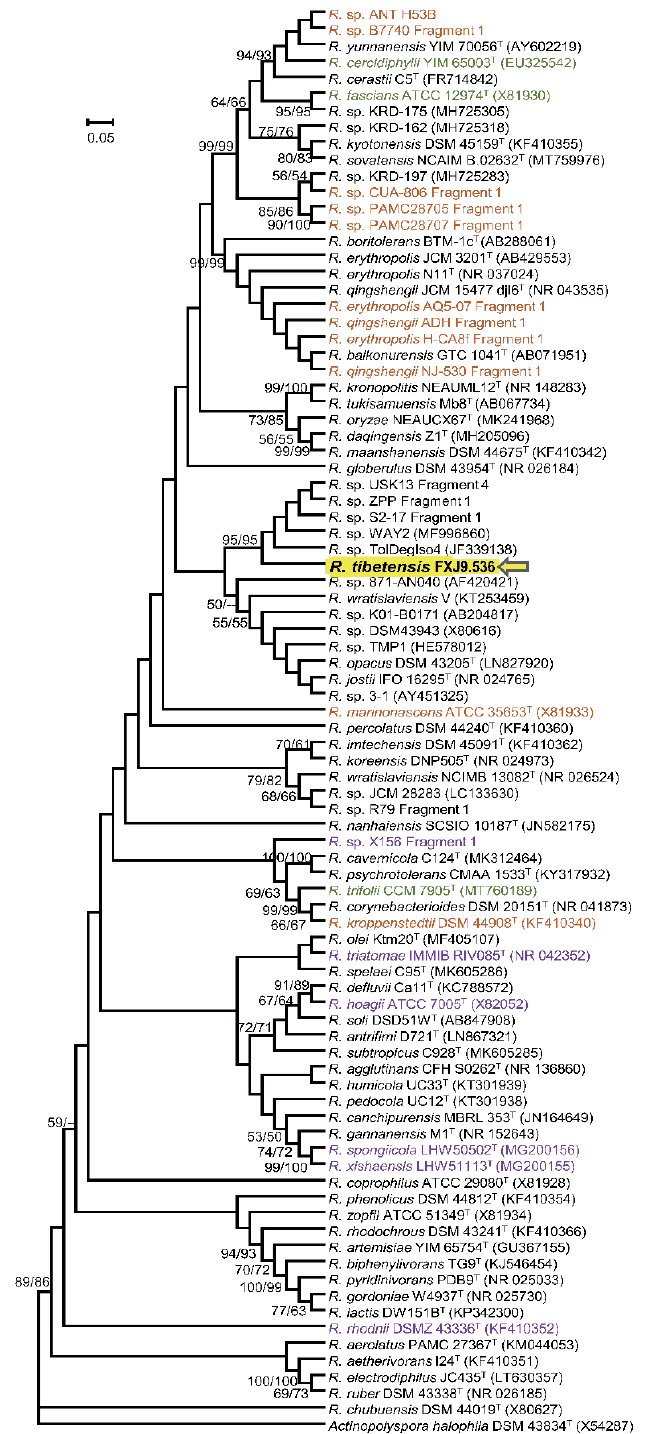
Figure 1. Maximum-likelihood phylogenetic tree based on 16S rRNA gene sequences of Rhodococcus spp. Actinopolyspora halophila DSM 43834 T (X54287) was used as an outgroup. Strains derived from plants, animals, and extreme environments (marine sediments, alpine regions, and polar regions), are highlighted in green, purple, and orange, respectively. Only bootstrap values above 50% are given. Bar, 0.05 substitutions per site.